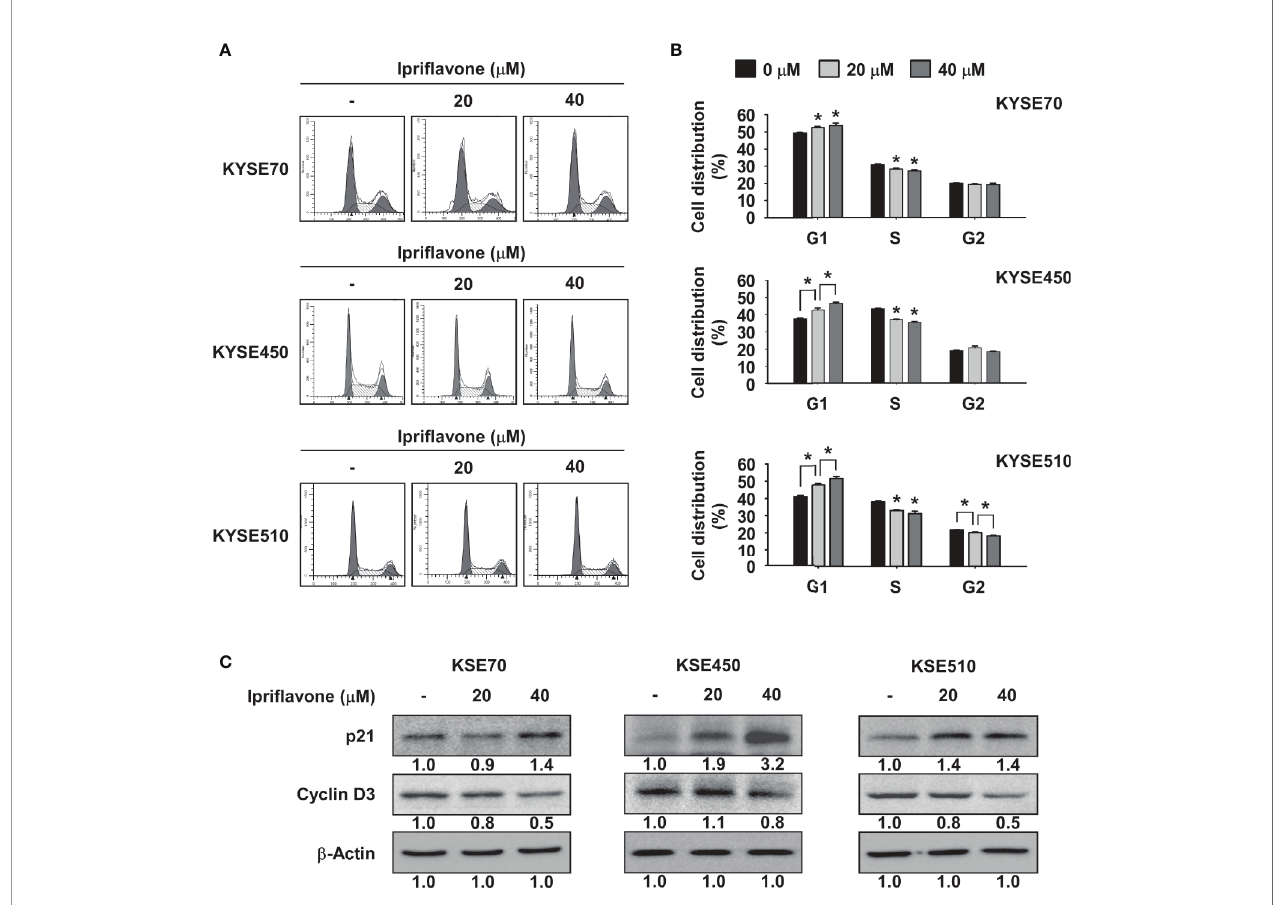
FIGURE 2 | Ipri fl avone induces G1 phase cell cycle arrest. (A, B) Effect of Ipri fl avone on cell cycle in ESCC cells. KYSE70, KYSE450 and KYSE510 cells were treated with Ipri fl avone for 48 h in 10% serum-supplemented medium. Cells were stained with propidium iodide (PI) and cell cycle was analyzed by Fluorescence Activated Cell Sorting (FACS). The bar graphs show the average DNA content corresponding to each cell cycle phase. For (A, B) , data are shown as means ± S.D. of triplicate values from 3 independent experiments and the asterisk (*) indicates a signi fi cant ( p < 0.05) difference. (C) Effect of Ipri fl avone on the expression of cell cycle marker proteins was determined by Western blotting. Band density was measured using the Image J (NIH) software program. For (C) , similar results were observed from three independent